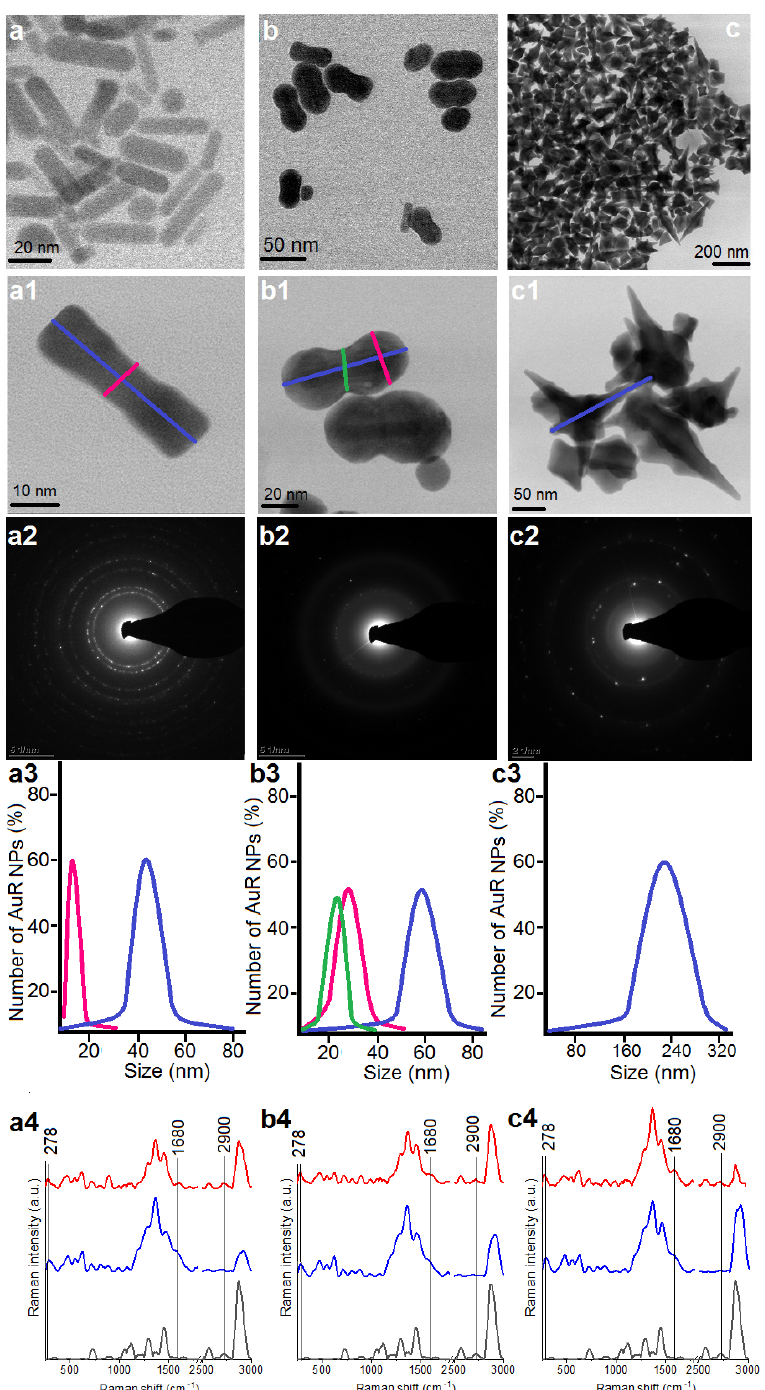
Figure 1. Overview STEM image of the obtained AuR NPs ( a , a1 ), AuP NPs ( b , b1 ), and AuS NPs ( c , c1 ); Selected area diffraction (SEAD) patterns of the AuR NPs ( a2 ), AuP NPs ( b2 ), AuS NPs ( c2 ); size distribution of the AuR NPs ( a3 ), AuP NPs ( b3 ), AuS NPs ( c3 ); and unenhanced Raman spectra of the MHDA (black spectra)-functionalized nanoparticles by MHDA (blue spectra) and immobilized CSA-131 in the NPs surface (red spectra) for the AuR NPs ( a4 ), AuP NPs ( b4 ), and AuS NPs ( c4 ).